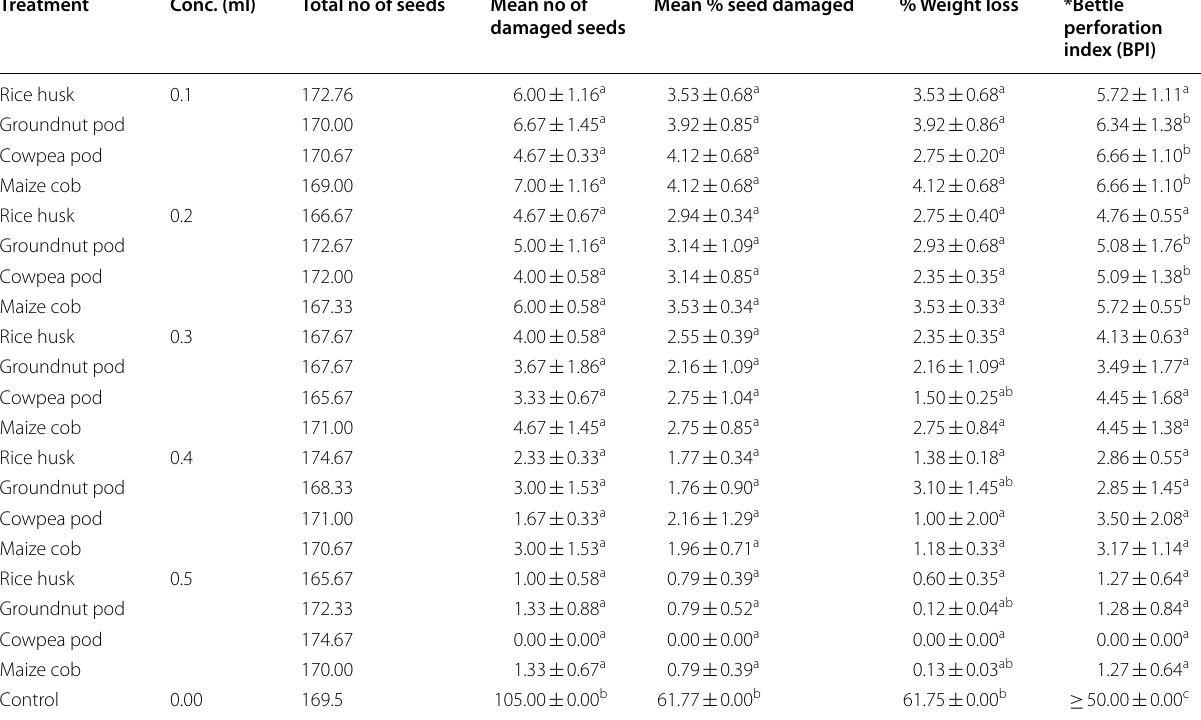
Mean followed by the same letters within the same column are not significantly different ( p >